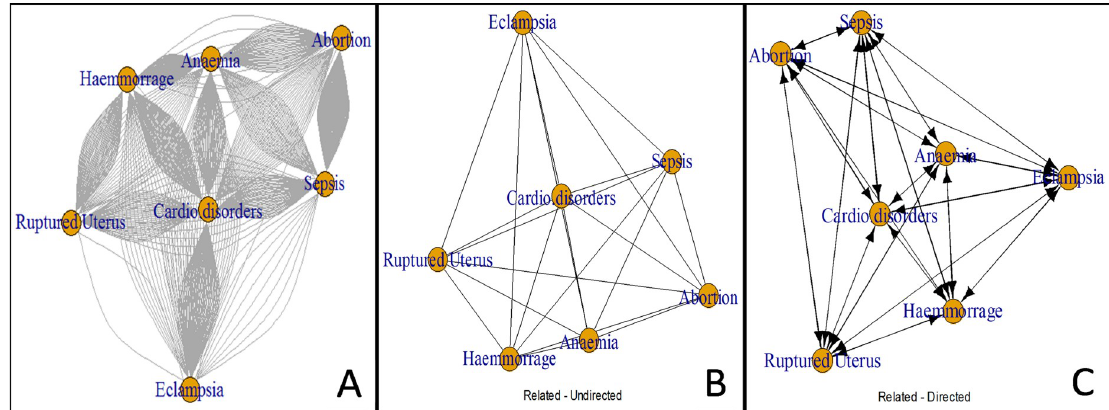
Fig 7. The relationship between main causes of maternal deaths indicating A) individual level network, B) related causes with no direction and C) related causes with